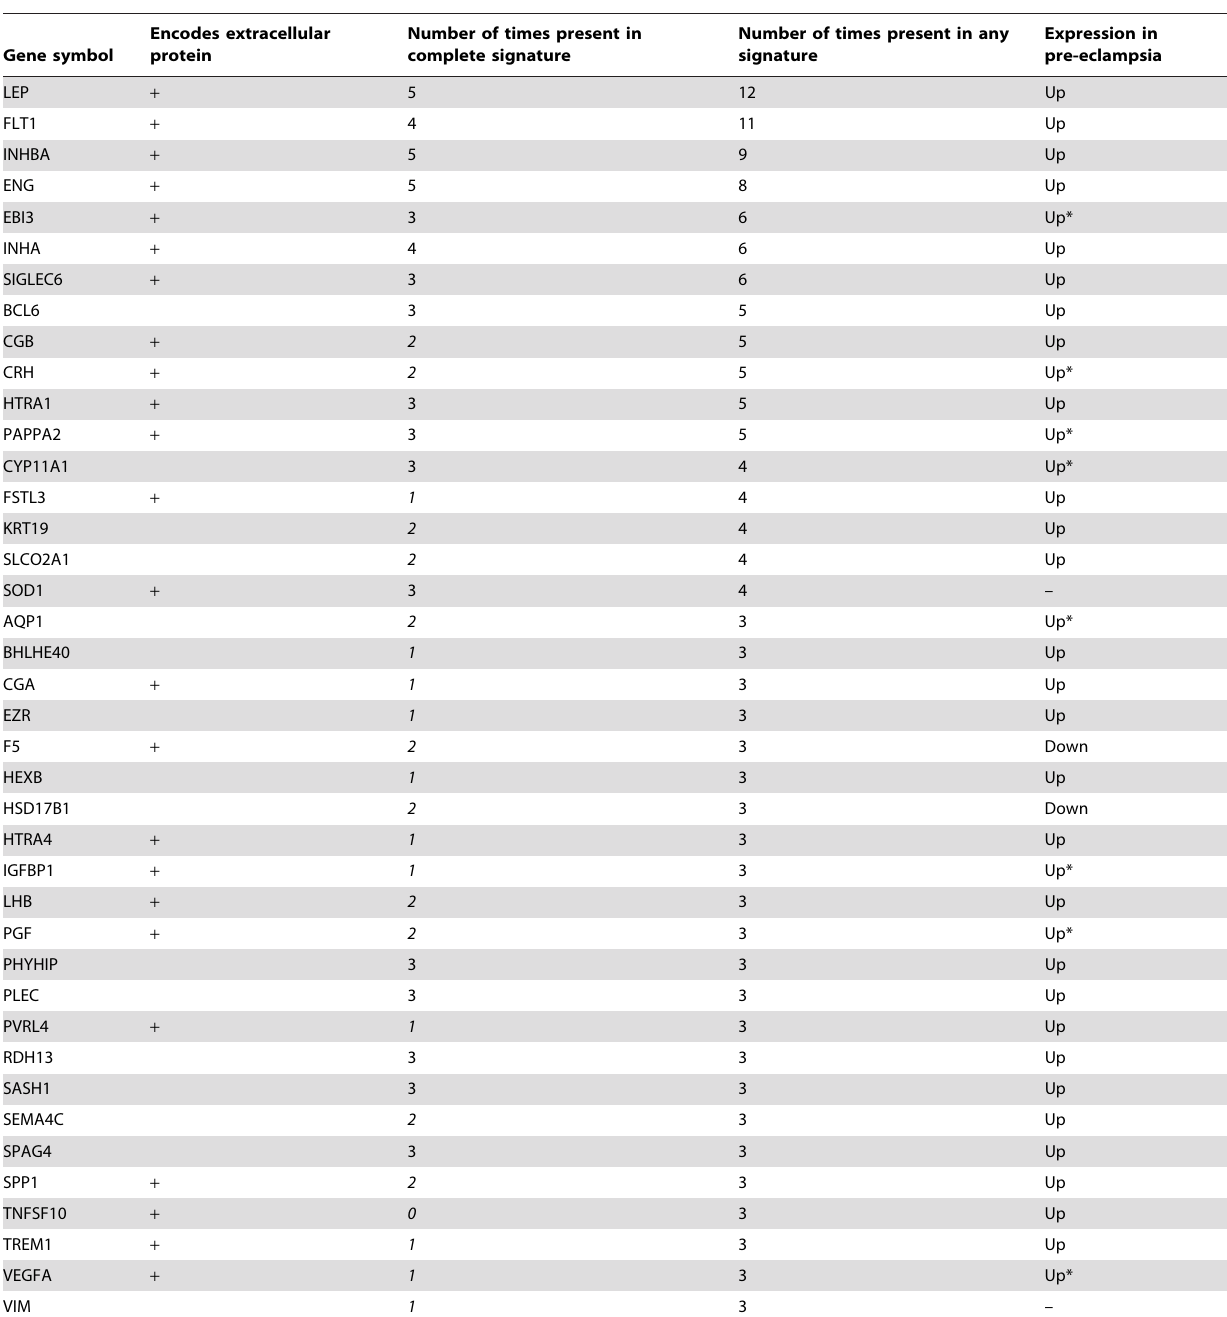
Table 1. Meta signature of third-trimester placental tissue mRNA expression.